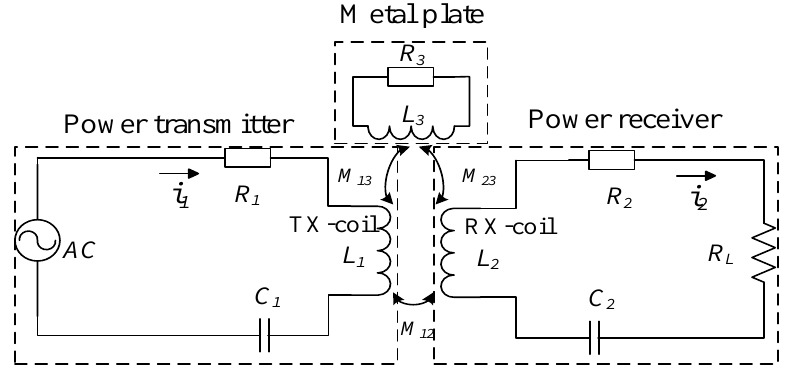
Figure 1. The equivalent circuit of the wireless power transmission (WPT) system.